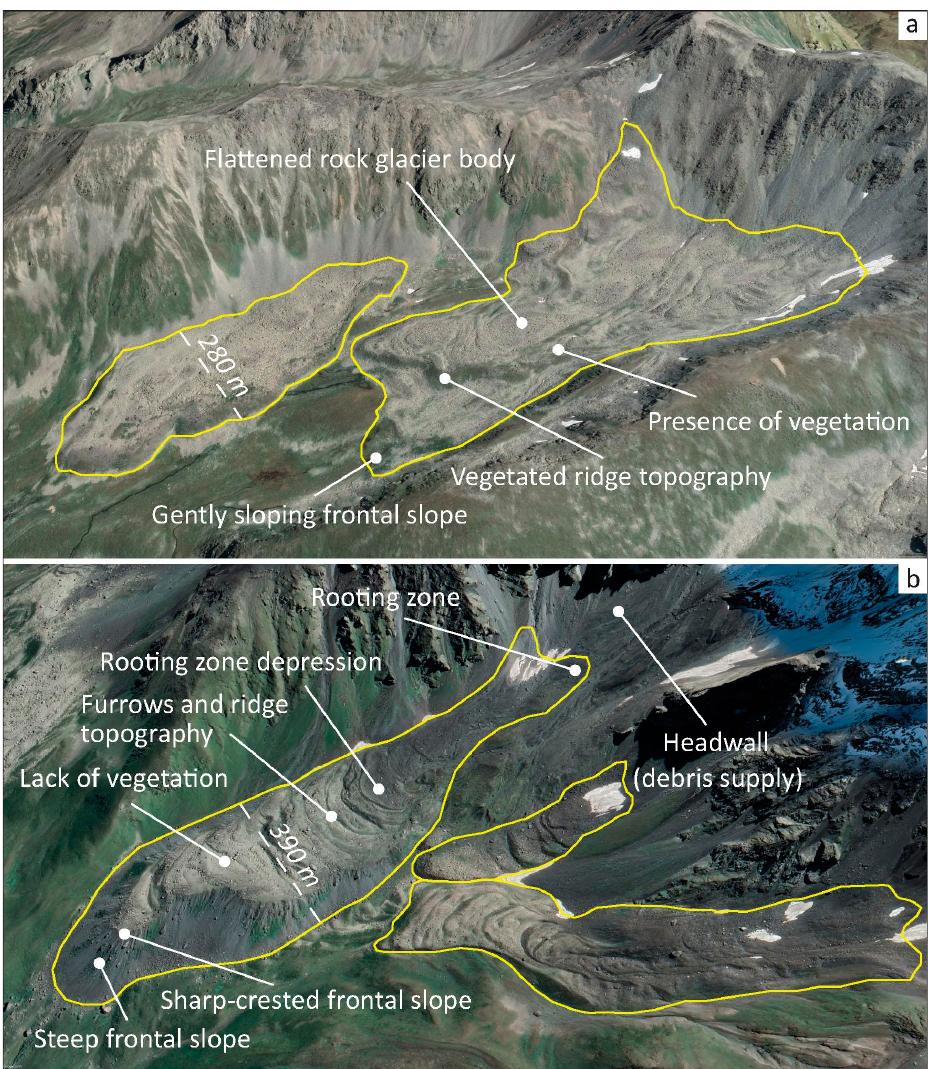
Figure 2. An example of rock glacier mapping and classification: ( a )—relict rock glaciers (43°38 ′ 21.36 ″ N 41°5 ′ 53.19 ″ E); ( b )—active rock glaciers (42°32 ′ 54.05 ″ N 44°46 ′ 31.21 ″ E). The yellow line corresponds to the boundaries of the rock glacier. The white dashed line indicates the width of the rock glacier. Google Earth imagery 16/08/2019 and 16/08/2022 is used as the background. © Google Earth 2022.